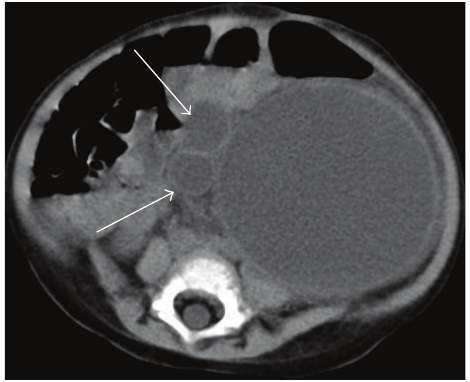
Figure 3: Computed tomographic scan of the abdomen showing a rounded appearance of the abdomen, markedly dilated and tortu- ous left ureter (arrows), and severe pelvicalyceal